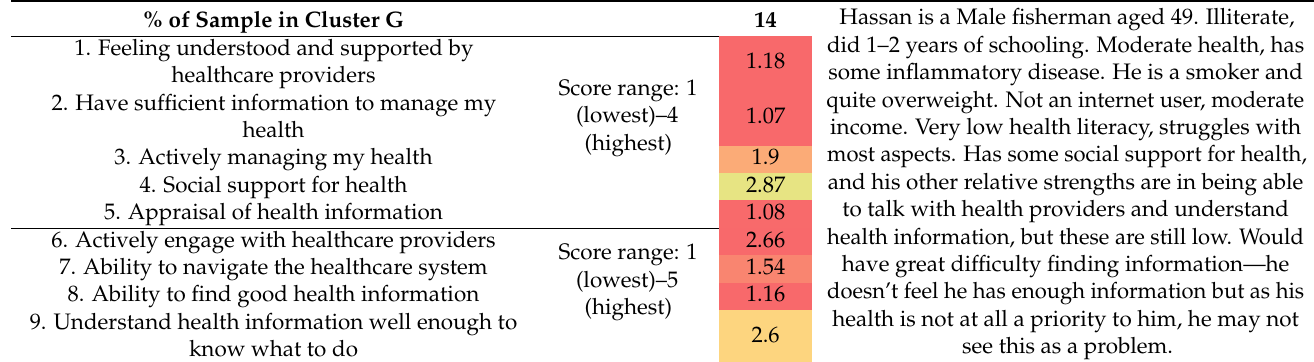
Table 4. Example of a vignette (Cluster